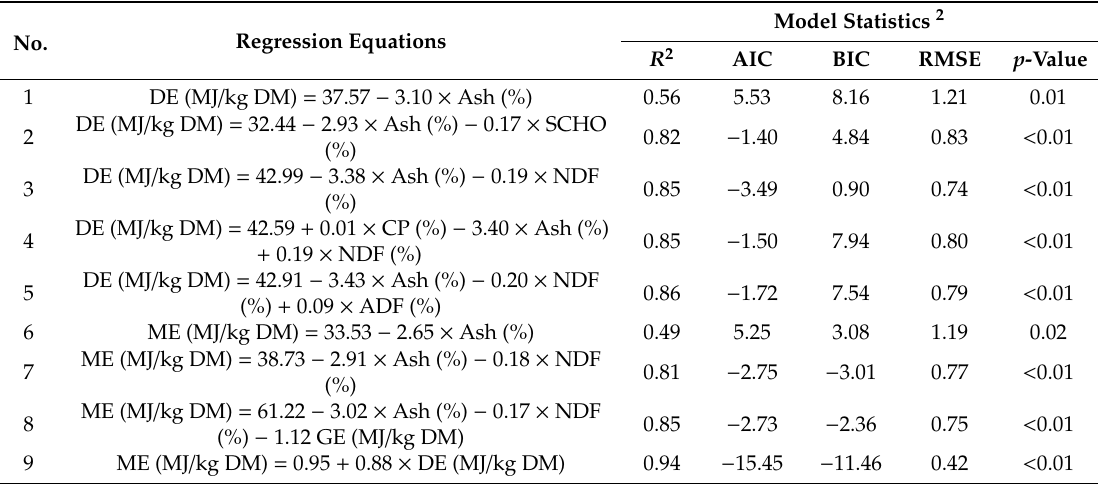
Table 11. Regression equations for digestible energy (DE) and metabolizable energy (ME) in soybean meal from and chemical characteristics 1 .